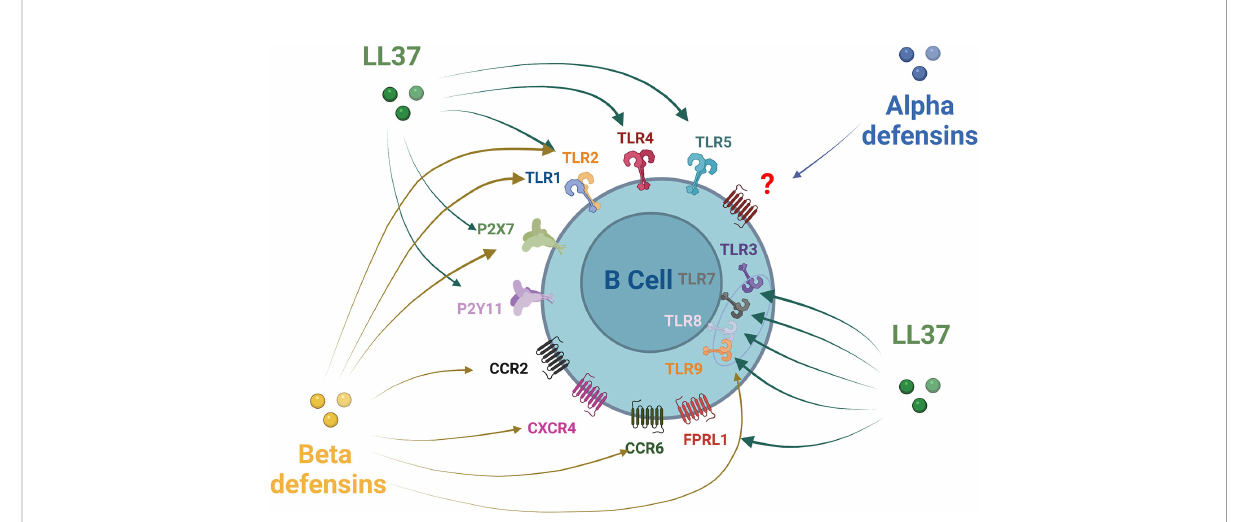
FIGURE 2 Antimicrobial peptides receptors expression on B-cells. Alpha defensin has been shown to recruit B-cells through a non-identi fi ed Protein G Coupled Receptor. Beta defensin family receptors are more documented with an action of HBD1 and HBD2 on CCR6 and HBD3 via CCR6, CCR2, CXCR4, P2X7, TLR1, TLR2, and TLR9. LL37 act on a larger number of receptors that can be expressed by B-cells: TLRs1-5, TLRs7-9, FPRL1 P2X7, and